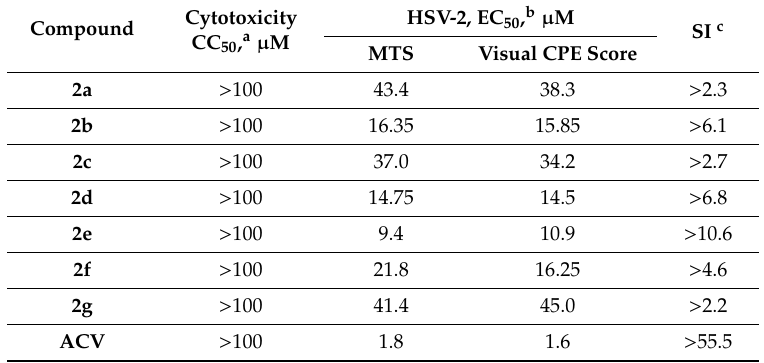
Table 2. Cytotoxicity and antiviral activity against Herpes simplex virus type 2 in HEL cell cultures.